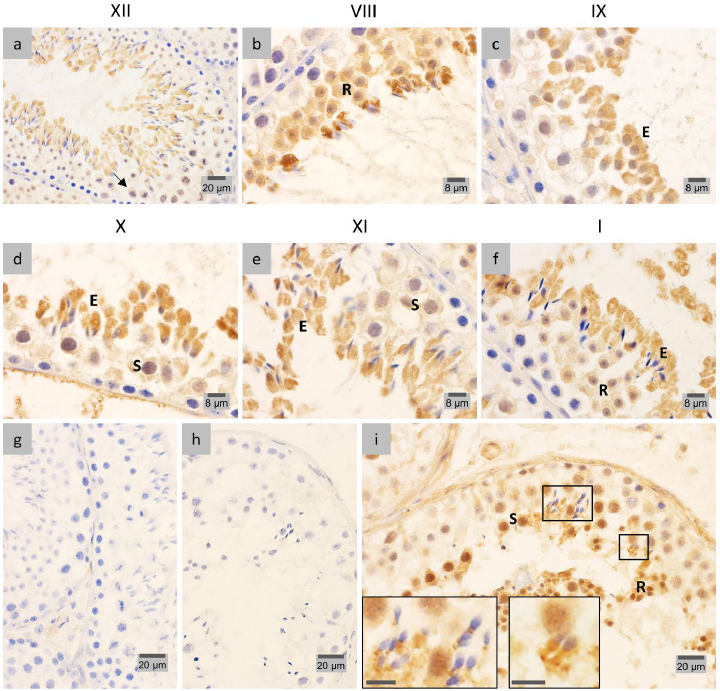
Figure 4. Immunohistochemical localization of PP1γ2 in mouse ( a – f ) and human ( g – i ) testis sections fixed in diluted Bouin’s solution. Positive immunostaining appears in brown color and nucleus counterstaining with hematoxylin. (a–f) Mouse spermatogenic stages wherein PP1γ2 expression is concomitant with LAP1 are depicted. (a) In stage XII seminiferous tubules (stages are indicated with Roman numerals), PP1γ2 concentrates in the cytoplasm of meiotic cells (arrow) and elongating spermatids. (b) Stage VIII round spermatids (R) present staining for PP1γ2 in both the nucleus and cytoplasm, whereas a high staining is visible in residual bodies of elongated mature spermatids. (c) High positive staining for PP1γ2 in the cytoplasm, centriolar pole and one half of the nucleus in stage IX elongating spermatids (E). (d) In stage X, in addition to PP1γ2 being found in the cytoplasm and nucleus of elongating spermatids (E), the same subcellular distribution is observed in spermatocytes (S). (e) Prior to meiosis, PP1γ2 distinctively stains the nucleus and cytoplasm of spermatocytes (S), but only the cytoplasm of stage XI elongating spermatids (E). (f) In stage I, round spermatids (R) show equal PP1γ2 staining in the nucleus and cytoplasm, while elongated spermatids (E) remain stained only in the cytoplasm. (g–i) PP1γ2 expression in human spermatogenic cells is depicted. (i) PP1γ2 concentrates in the nucleus and cytoplasm of pachytene spermatocytes (S), as well as round spermatids (R), progressively shifting to the centriolar pole of elongating spermatids (right ROI, scale bar: 8 μm) and elongated mature spermatids (left ROI, scale bar: 8 μm). (g,h) Negative controls showed no PP1γ2 staining. PP1: protein phosphatase 1. ROI: region of interest.